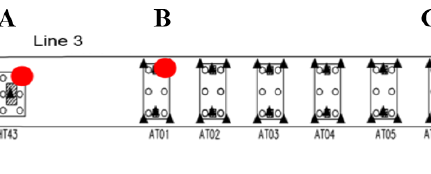
Figure 8. Layout of measuring points of different piles. Figure 9. Layout of soil settlement measuring points around the excavation.